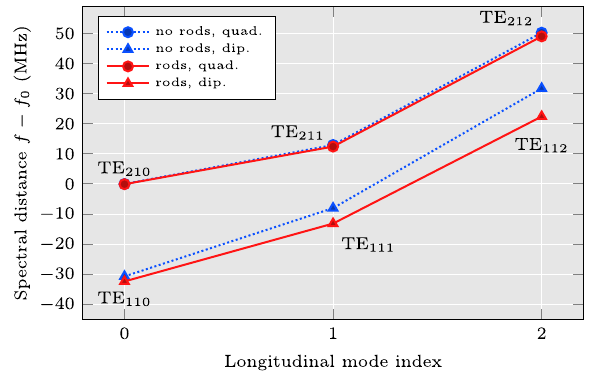
visualization).FIG. FIG. 7. Magnetic field (surface current density) at the output end. (a) Undercut window with the maximum tangential mag- netic field throughout the entire RFQ at the undercut edge. (b) Field at the dipole stabilization rod. (Different color scales are used for clearer